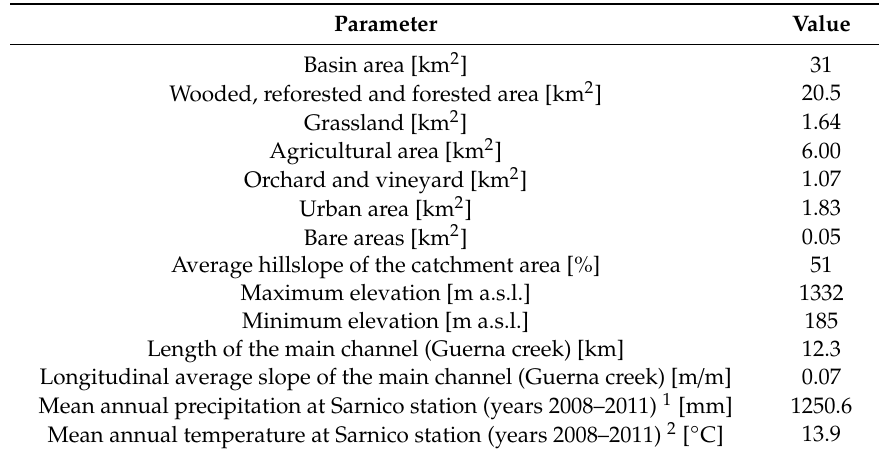
Table 1. Main features of the Guerna creek